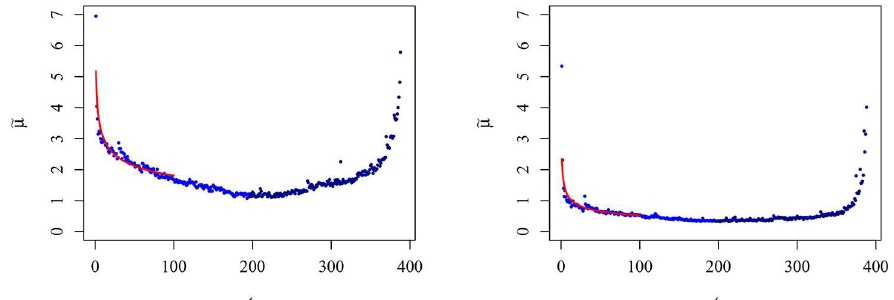
Fig 1. Average trading volume, ~ m ð t ; d Þ v intraday time (minutes). The left panel is for 2S06 and the right panel for 1S13. In both cases we use different tones of blue to represent the morning and evening part of the sessions. The red line represent the numericalfit obtainedfor Eq (9). In both panels the volume is divided by 10 4 .